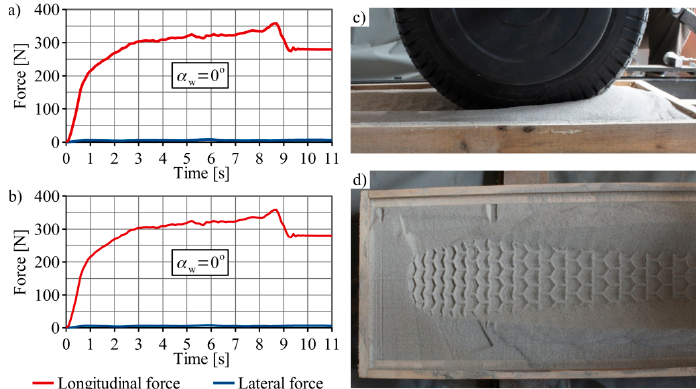
Figure 3. Graphs of the measured longitudinal and lateral forces relative to the direction of movement ( a ), as well as the calculated longitudinal and lateral forces relative to the geometry of the wheel ( b ), for α w = 0°. The wheel on the experimental stand after the test ( c ) and the resulting tire track ( d ) [21].